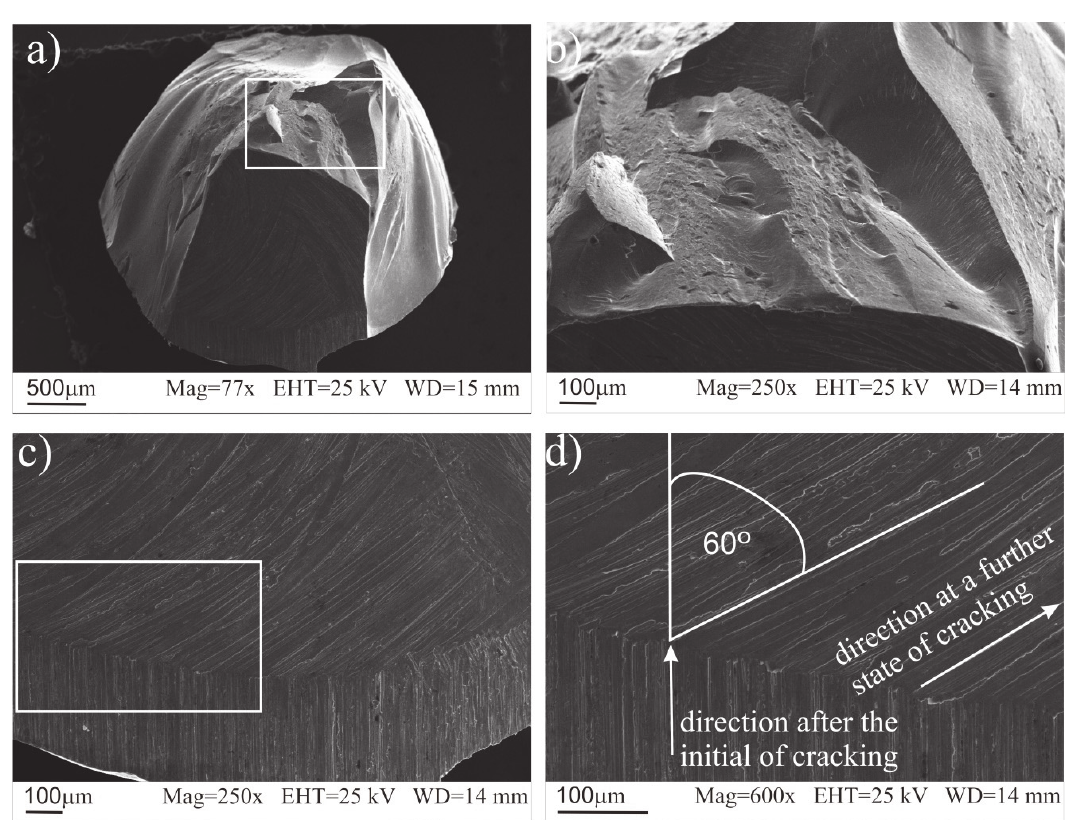
Figure 5: SEM images of the fracture morphology of Fe 36 Co 36 B 19 Si 5 Nb 4 alloy rod with diameter of  =4 mm after compressive fracture; a – main view: vein and smooth pattern regions, b – image of fracture near the core of rod, smooth and vein patterns, c, d – image of fracture outside surface, vein patterns, d – magnified veins from the area as point in (c). White arrows indicate the direction after the initial of cracking and direction at a further state of